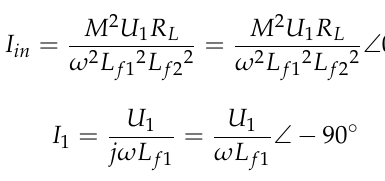
Figure 15. General block diagram of the system.